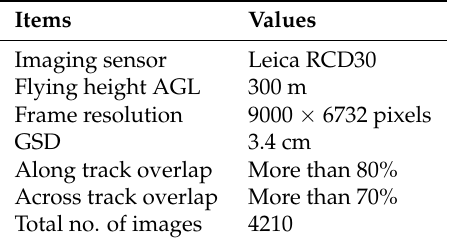
Table 2. Specifications of the utilized imaging sensor and the acquired images. GSD: ground sampling distance.